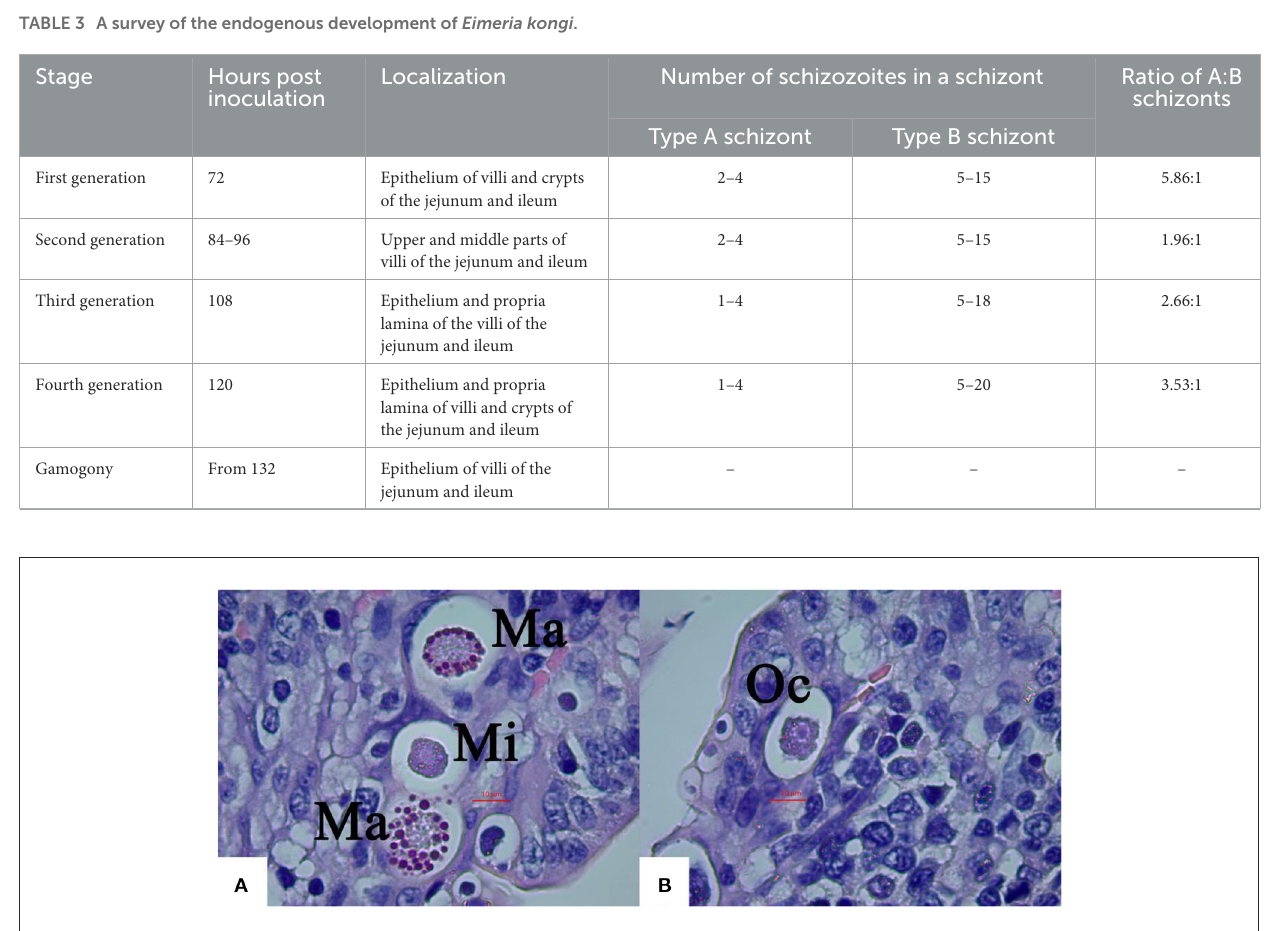
Fully formed oocysts occurred in the feces of the infected rabbits 6